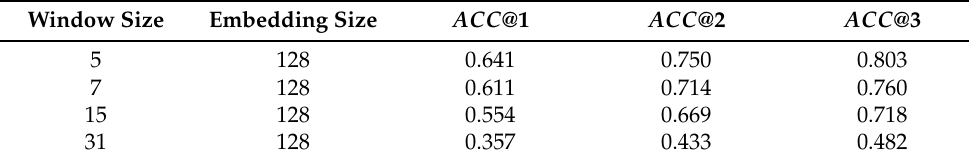
Table A1. Results for the best LSTM model with different window sizes.